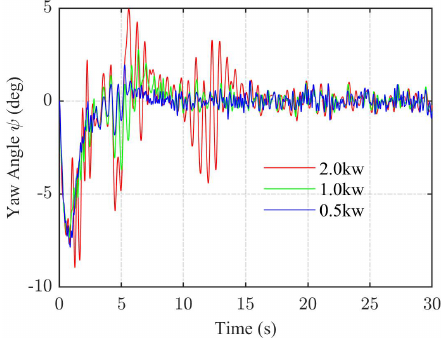
Figure 13. Steady-state accuracy for different model